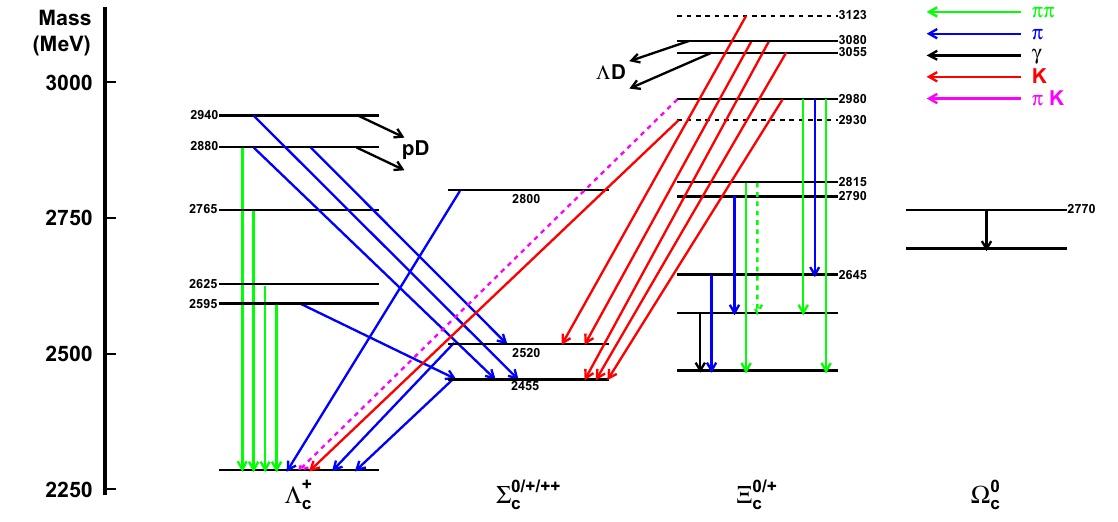
Fig. 216 Level diagram for multiplets and transitions for excited charm baryons